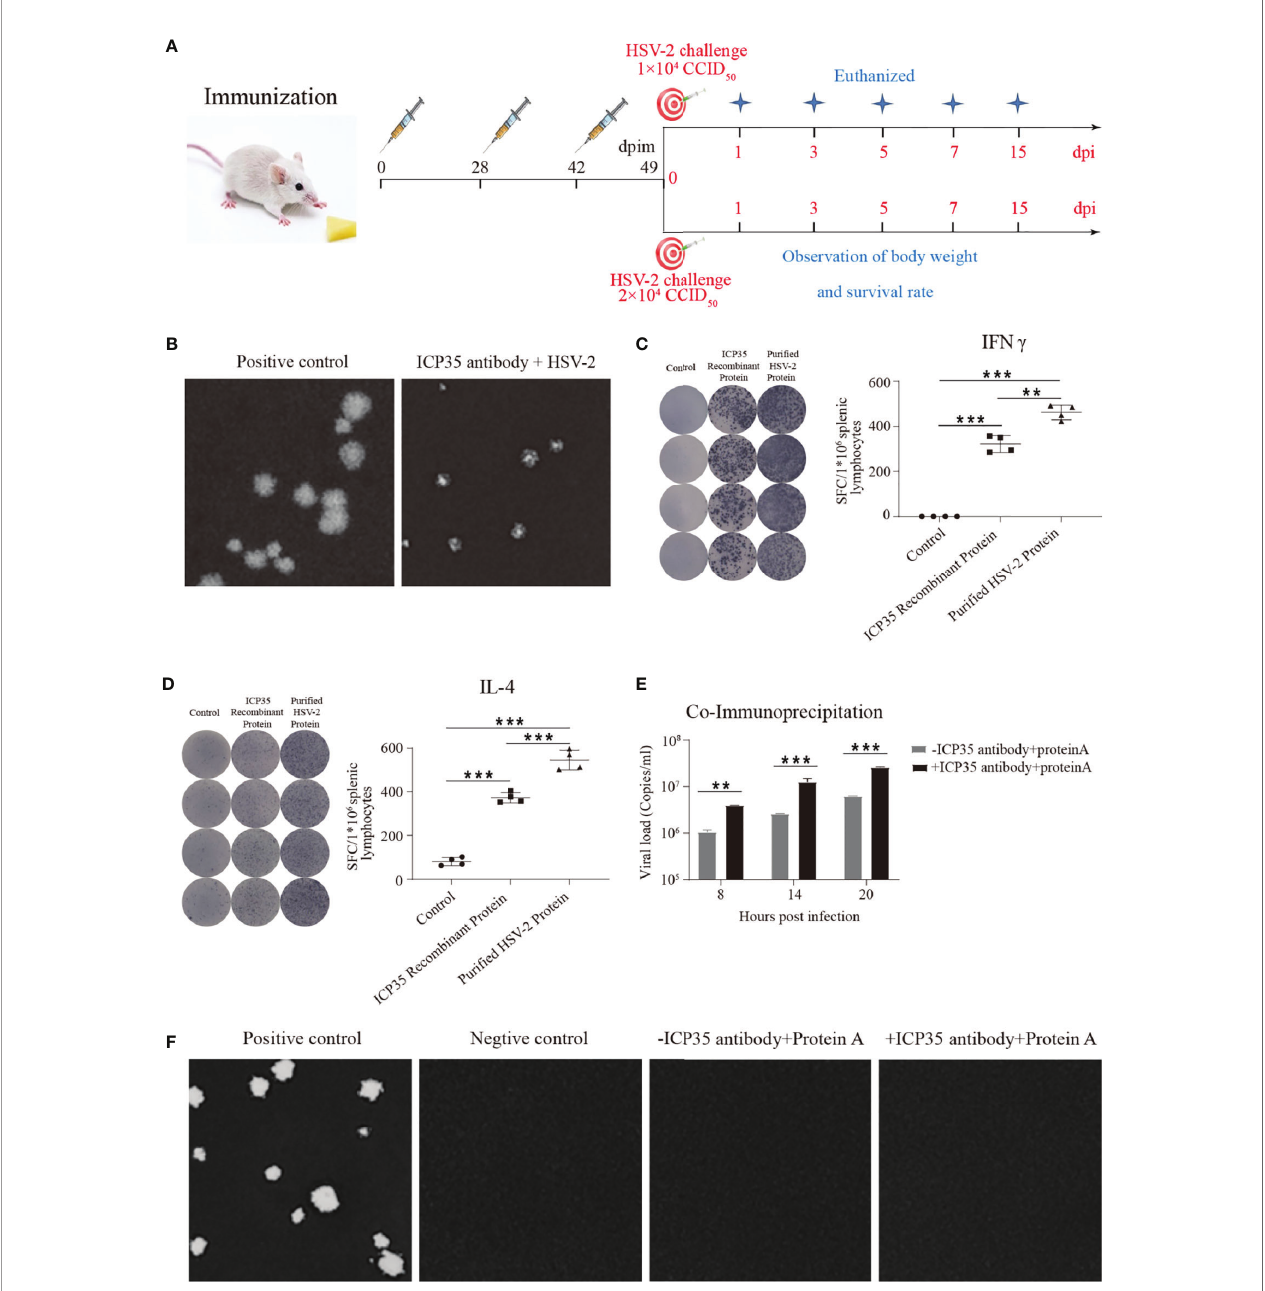
FIGURE 3 | The integrated immune responses elicited by ICP35. (A) Schematic of ICP35 immunization and viral challenge protocols in the mice. (B) The addition of anti-ICP35 antibody restricted the sizes of the plaques. The positive control refers to HSV2 and normal serum samples; ICP35 antibody+HSV-2 refers to HSV2 and anti-ICP35 serum samples. (C) The ELISPOT analysis of ICP35 elicited IFN- g -secreting T cell responses in ICP35 protein-immunized mice at day 28 after the last immunization (n=3). The spot diagram (left) and result (right) of IFN- g were shown. Samples from the ICP35-immunized animals were stimulated with the ICP35 recombinant protein and puri fi ed HSV-2 protein. Samples were run in duplicate. (D) The ELISPOT analysis of ICP35 elicited IL-4-secreting T cell responses in ICP35 protein-immunized mice at day 28 after the last immunization (n=3). The spot diagram (left) and result (right) of IL-4 were shown. Samples from the ICP35-immunized animals were stimulated with the ICP35 recombinant protein and puri fi ed HSV-2 protein. Samples were run in duplicate. (E) Fluorescence quantitative PCR of protein A agarose gel particle sediment. -ICP35 antibody + protein A: the cell lysate supernatants infected HSV2 were incubated overnight without the anti-ICP35 antibody at 4°C; +ICP35 antibody + protein A: the cell lysate supernatants infected HSV2 were incubated overnight with the anti-ICP35 antibody at 4°C. (F) Plaque assay of protein A agarose gel particle sediment. The positive control refers to infection with HSV2 virus. The negative control refers to cells. -ICP35 antibody + protein A: the cell lysate supernatants infected HSV2 were incubated overnight without the anti-ICP35 antibody at 4°C; +ICP35 antibody + protein A: the cell lysate supernatants infected HSV2 were incubated overnight with the anti-ICP35 antibody at 4°C. **P<0.01,